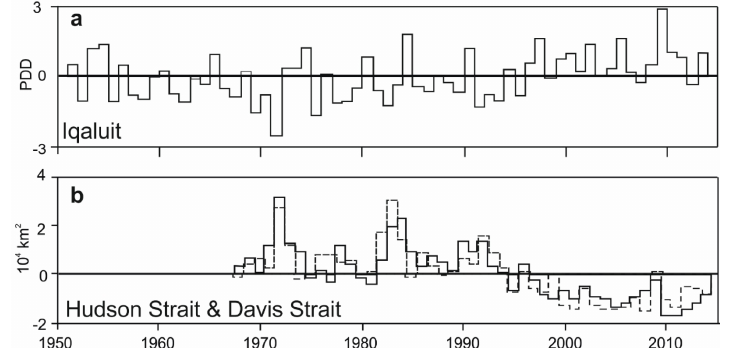
Figure 9. (a) Annual anomalies in total positive degree-days (PDD) recorded from April to November at the Iqaluit weather station, 1952 to 2014, based on Homogenized Canadian Historical Climate Data (Vincent et al., 2015). (b) Anomalies in total sea-ice covered area during the summer and autumn (25 June–19 November) over Hudson Strait (full line) and Davis Strait (dashed line), 1968–2014. Data provided by the Canadian Ice Service. For region boundaries, see Tivy et al. (2011), Fig.